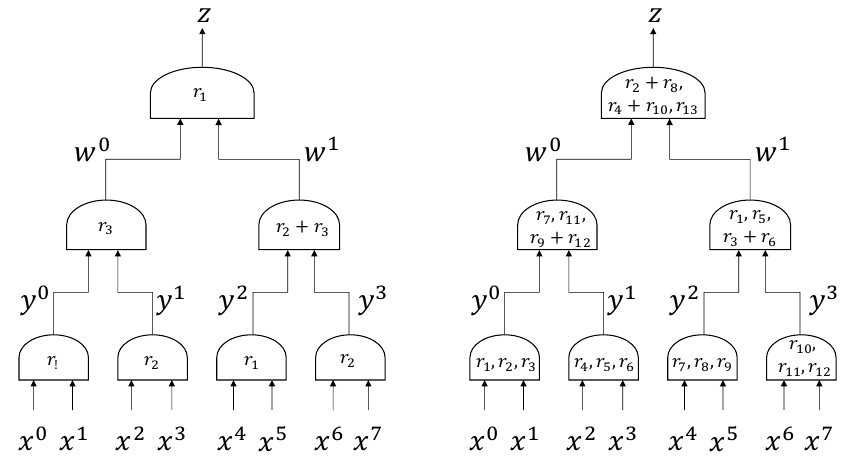
Figure 18: First- (left) and second-order (right) Kronecker Delta. Notation is adapted for